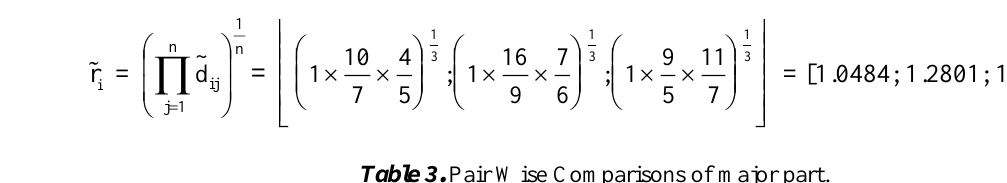
Table 3. Pair Wise Comparisons of major